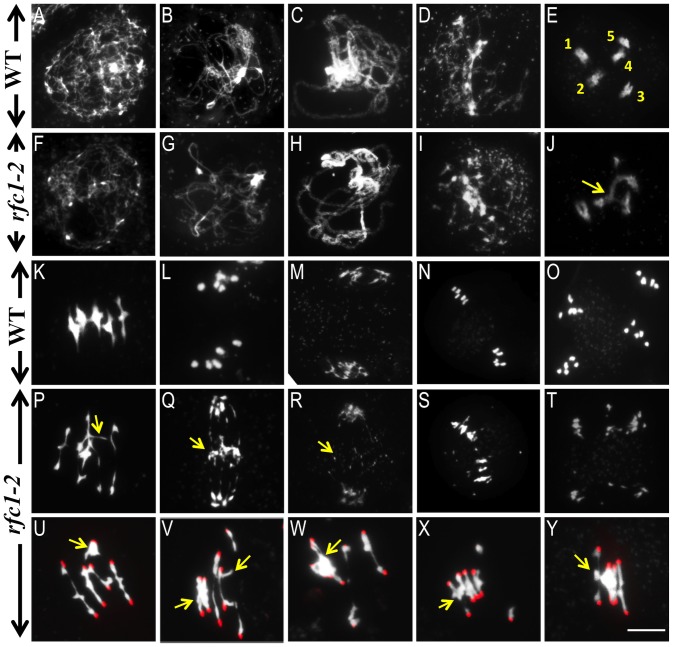
Male meiosis in wild type and rfc1-2.
(A–D) Wild type chromosome behavior at leptotene, zygotene, pachytene and diplotene, respectively. (F–I) rfc1-2 chromosome phenotypes were similar to the wild type up to diplotene. (E and J) Wild type diakinesis meiocytes showed five pairs of attached condensed homologs (bivalent, marked with number), but the mutant formed multivalents frequently instead of normal bivalents (arrow points to the association of more than two chromosomes). (K) Five bivalents aligned at the equator at metaphase I in the wild type, but the mutant showed non-homologous interaction (arrow) at a similar stage (P). (L) The homologs were separated by the spindle in wild type after metaphase I. Anaphase I (L and Q), Telophase I (M and R), Metaphase II (N and S) and Telophase II (O and T). The mutant showed chromosome fragmentation from anaphase I to telophase II (arrow). (U–Y) The rfc1-2 meiocytes formed abnormally long bivalents and multivalents that involved two (U and V), three (W), four (4) and five pairs of chromosomes (Y) (arrow). Red dots represent the centromere signals by FISH. Bar, 10 µm.